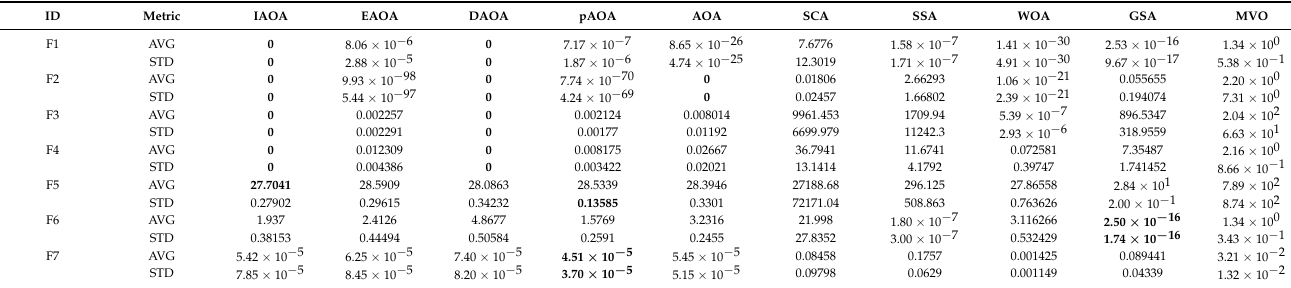
Table 1. Results of the single-peak function test with 30 dimensions.